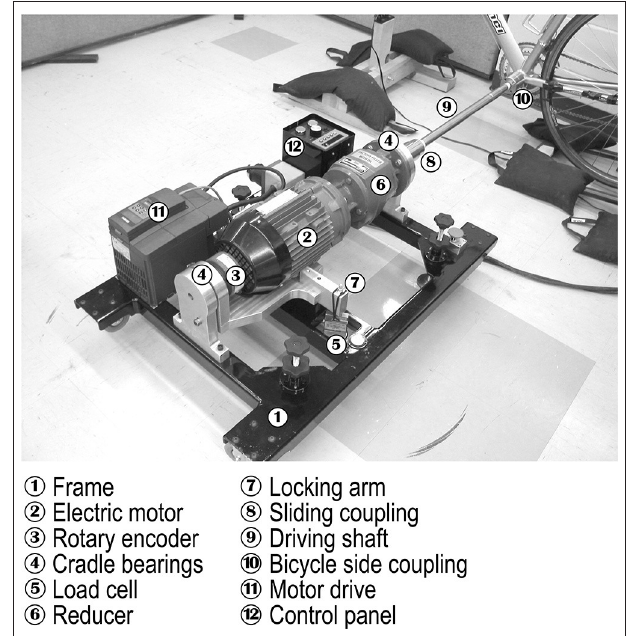
FIGURE 1 | Experimental